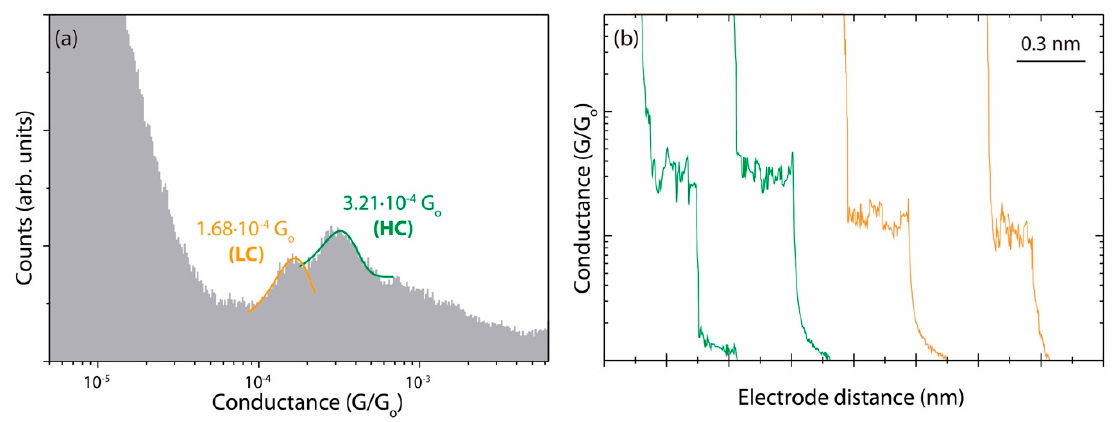
Figure 2. ( a ) Semi-logarithmic histogram from dynamic break junction (BJ) experiments for trans-TMC displaying a high conductance peak (HC, green traces) and a low conductance peak (LC, orange traces) fitted with Gaussians. ( b ) Representative individual current versus gap distance traces. V bias = 20 mV.